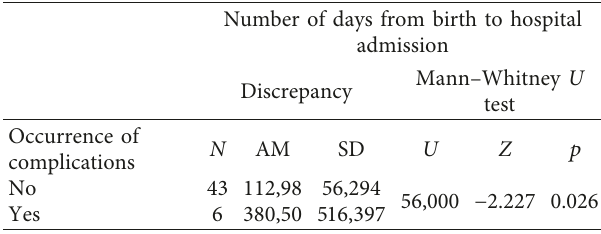
Table 3: Differences between patients with and without